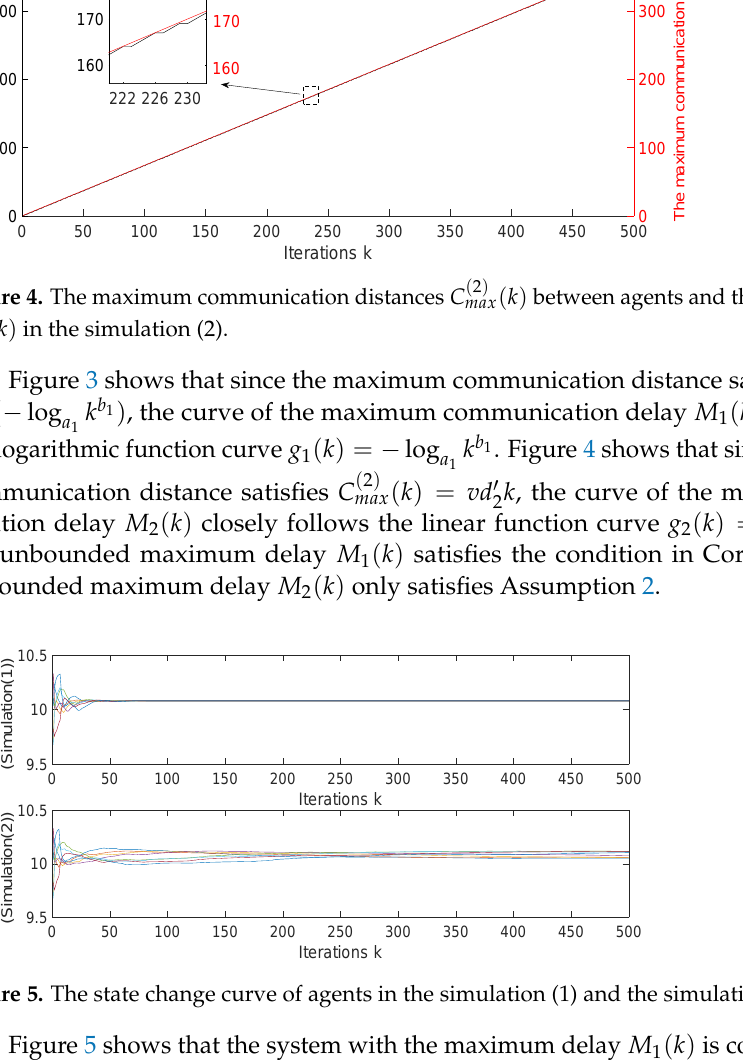
( 2 ) ( k ) between agents and the maximum delays max